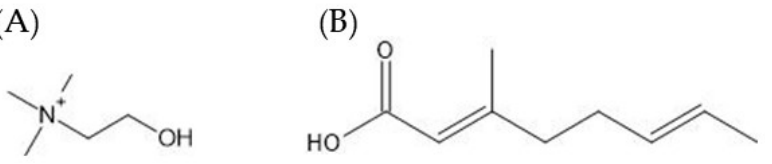
Figure 4. Chemical structure of individual components of CAGE, ( A ) choline bicarbonate and ( B ) geranic acid.